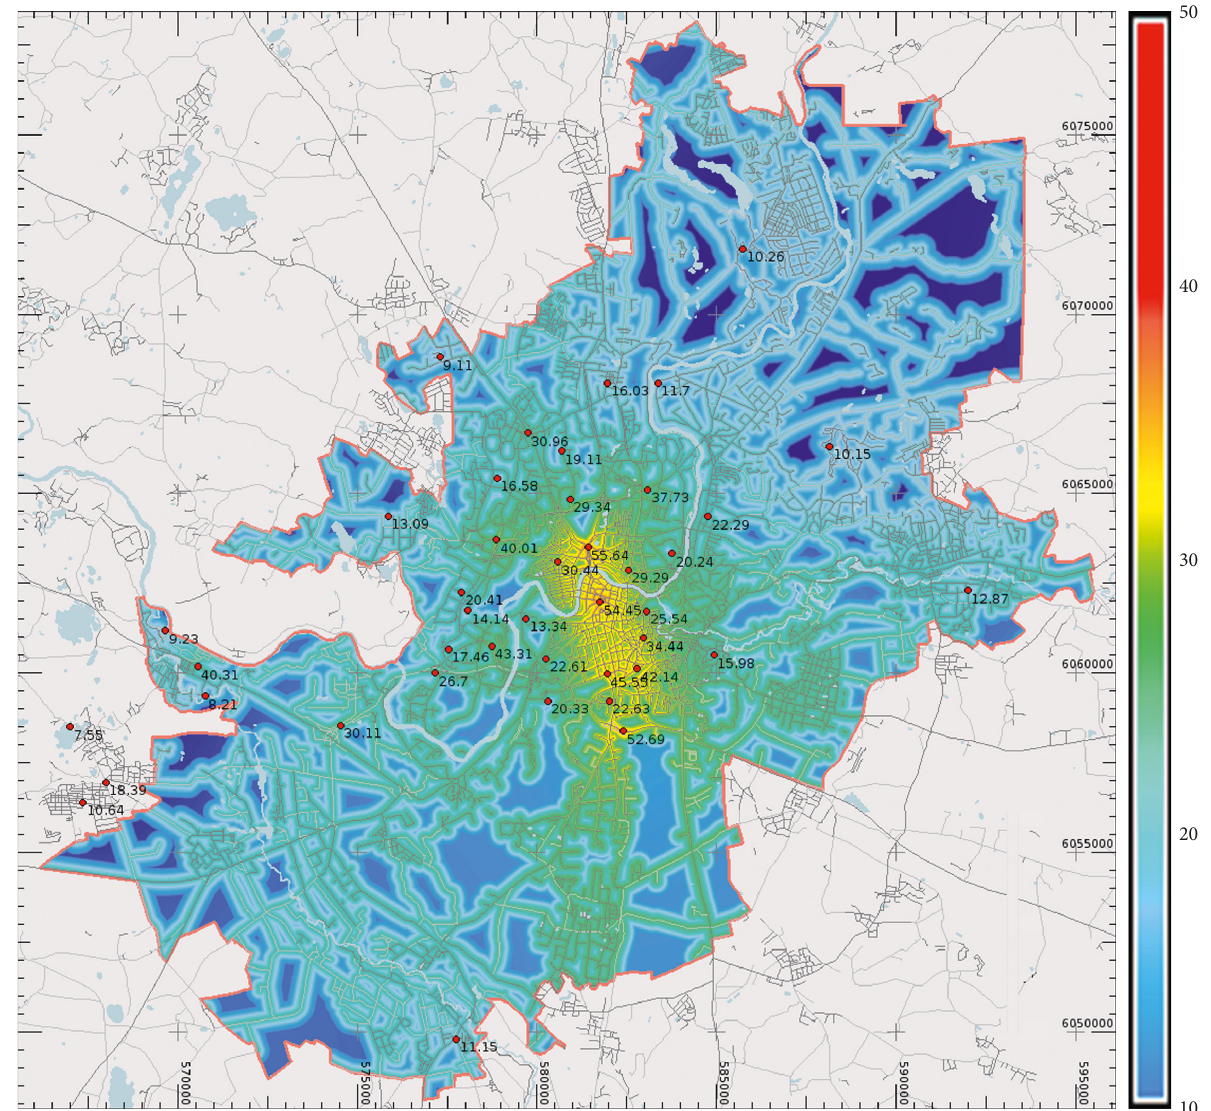
Figure 6: Annual mean concentrations of NO 2 in Vilnius agglomeration for the period from 3 November 2010 to 4 July